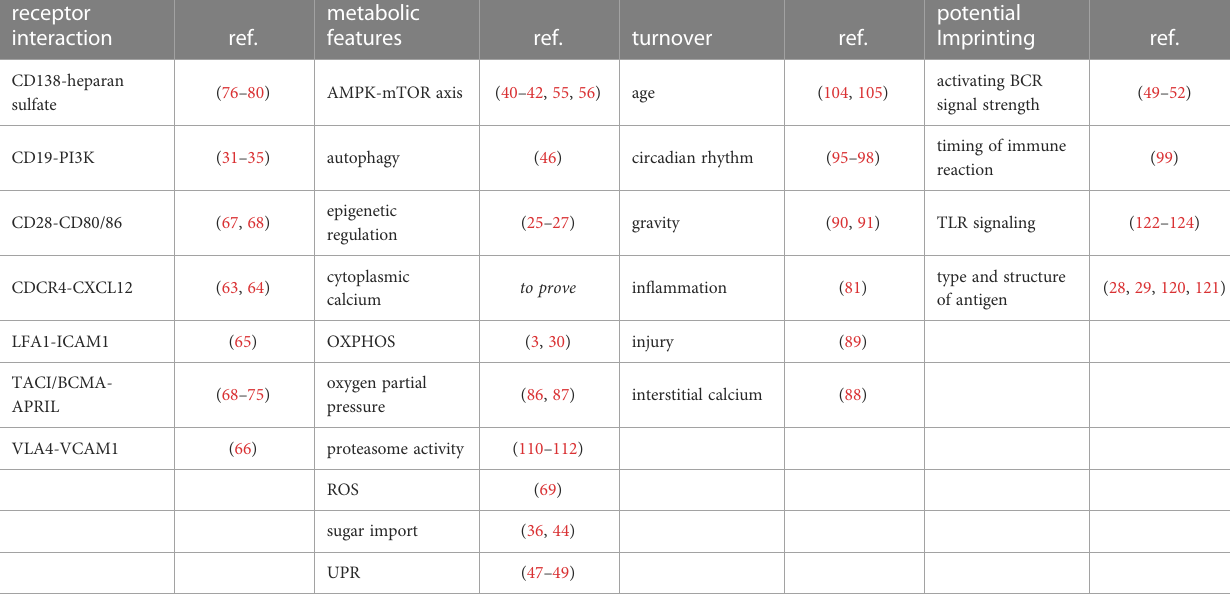
TABLE 1 Extrinsic and intrinsic factors impacting on survival and longevity of BMPC (alphabetical order). receptor interaction ref.